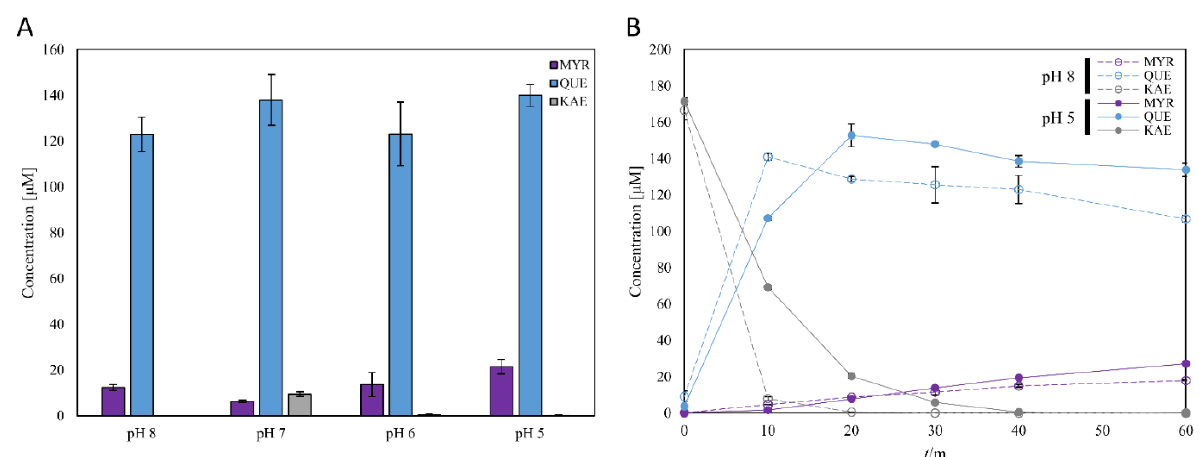
Figure 5. Kaempferol conversion of Bm Ty at different pHs. Concentrations of flavonols in one-hour Bm Ty reaction at pH 5~8 were shown as gray (kaempferol), blue (quercetin), and purple (myricetin) bars ( A ) and the concentrations of time course reactions at pH 5 and 8 were expressed with the same color for each compound ( B ). Concentrations at pH 8 were expressed with dashed lines and open circles and those at pH 5 were expressed with solid lines and closed circles.